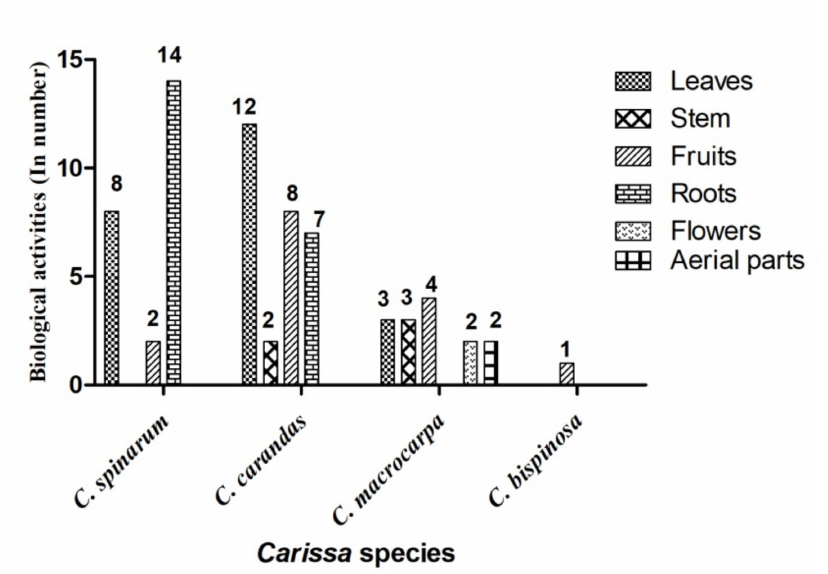
Figure 4. Ratio of biological activities screened during the analysis of the literature from C. spinarum , C. carandas , C. macrocarpa , and C.